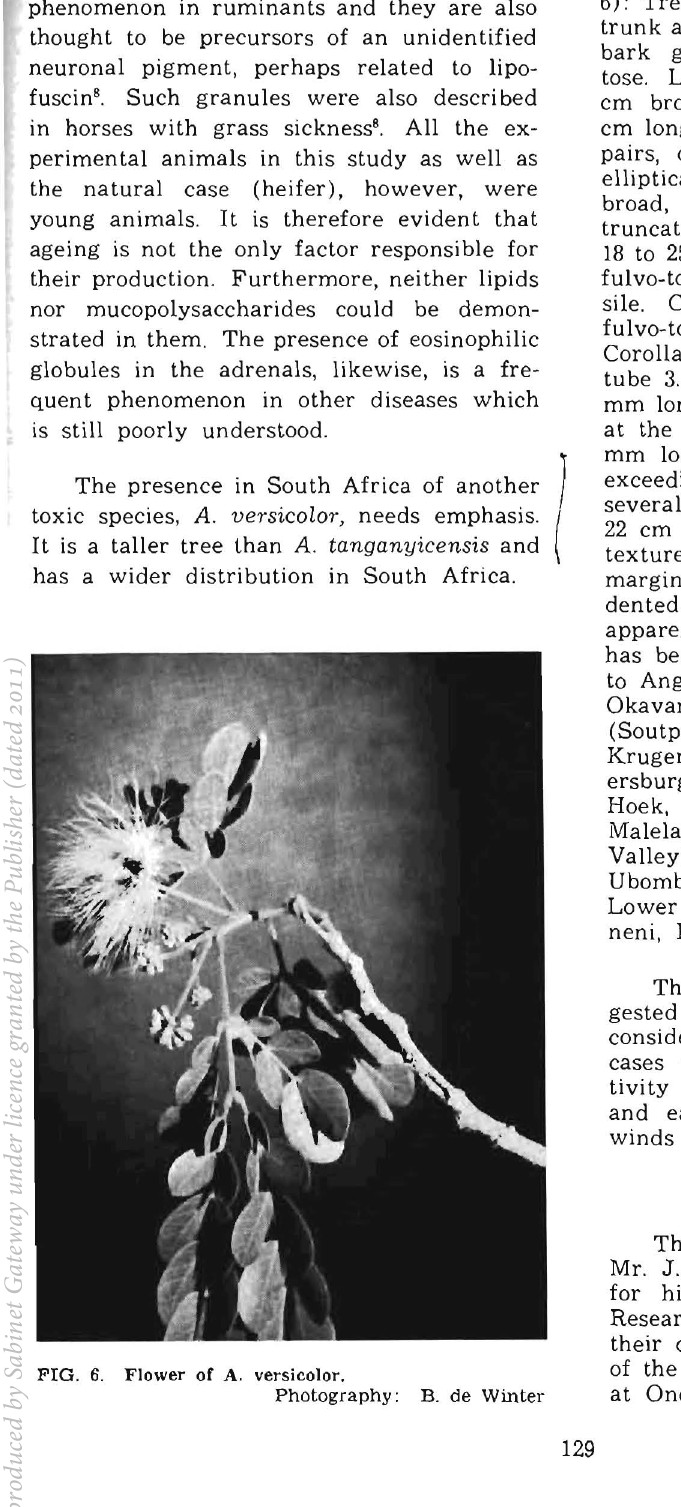
FIG. 6. Flower of A. versicolor. Photography: B. de